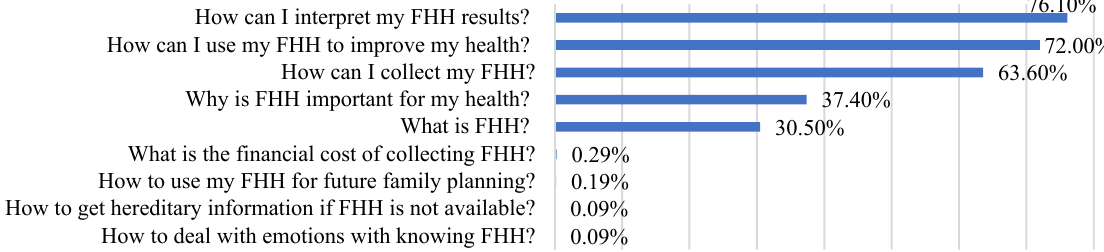
Figure 2. Participants’ preferred FHH educational topics ( n = 1050). FHH: family health history.